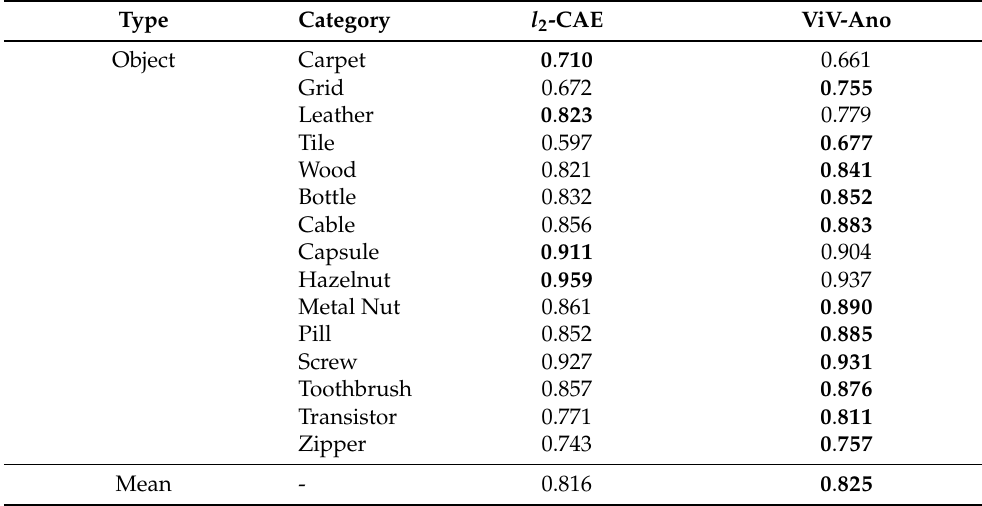
Table 4. Performance comparison of anomaly localization methods for